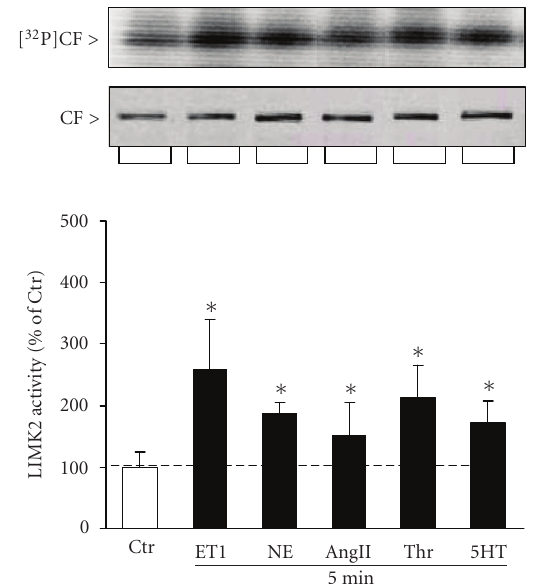
Figure 4: Contraction agonists activate LIMK2 in canine PASMCs. Canine PASMCs were incubated with thrombin (Thr), nore- pinephrine (NE), endothelin-1 (ET1), angiotensin II (AngII), and 5-hydroxytryptamine (5-HT) for 5min. LIMK2 was immunopre- cipitated from total protein homogenates and kinase activity was assayed by the phosphorylation of recombinant CF in the presence of [ γ - 32 P ]ATP in vitro. Reaction protein was resolved by SDS-PAGE, gels were stained with Coomassie brilliant blue and then exposed on phosphorimaging screens. CF radioactive bands (top inset) were normalized to protein bands (lower inset) and the agonist-mediated activation of LIMK2 was expressed as percentage of the activity of untreated cell controls (Ctr, bar graph). Mean ± SD, ( ∗ ) P < . 05 compared to untreated controls, n =